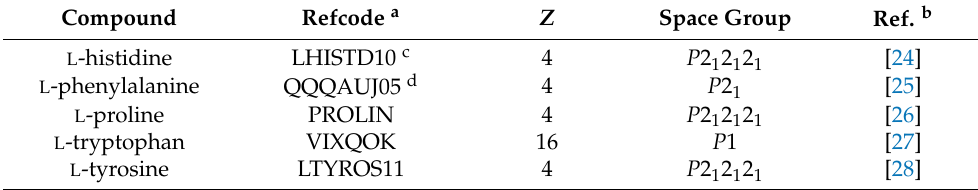
Table 2. Initial crystal structures of amino acids studied at (298.15 ± 3) K and p = (100 ± 5) kPa.